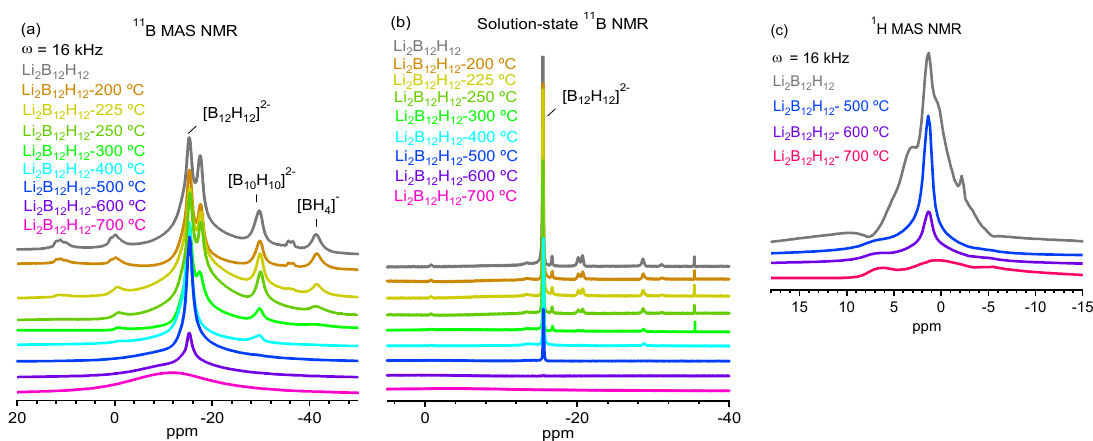
Figure 2. Ex-situ ( a ) X-ray diffraction (XRD) patterns and ( b ) Raman spectra of anhydrous Li 2 B 12 H 12 and heated up to respective temperatures.